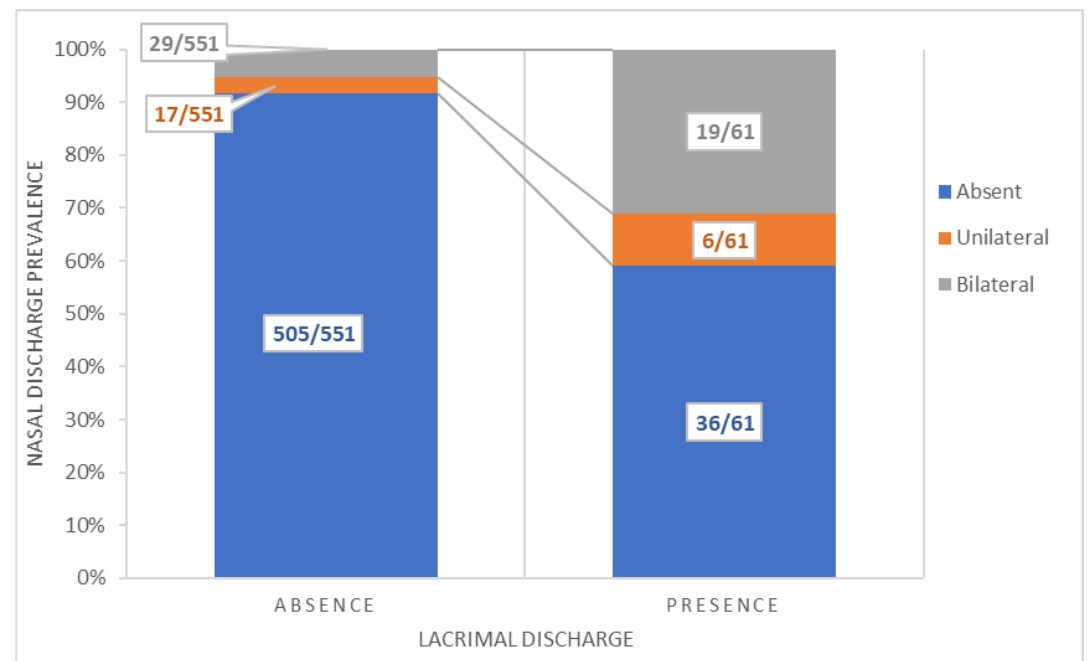
Figure 3. Association between the presence of lacrimal discharge and the severity of nasal discharge (absent, unilateral, or bilateral) in the 613 handled horses transported to two slaughterhouses in Italy.